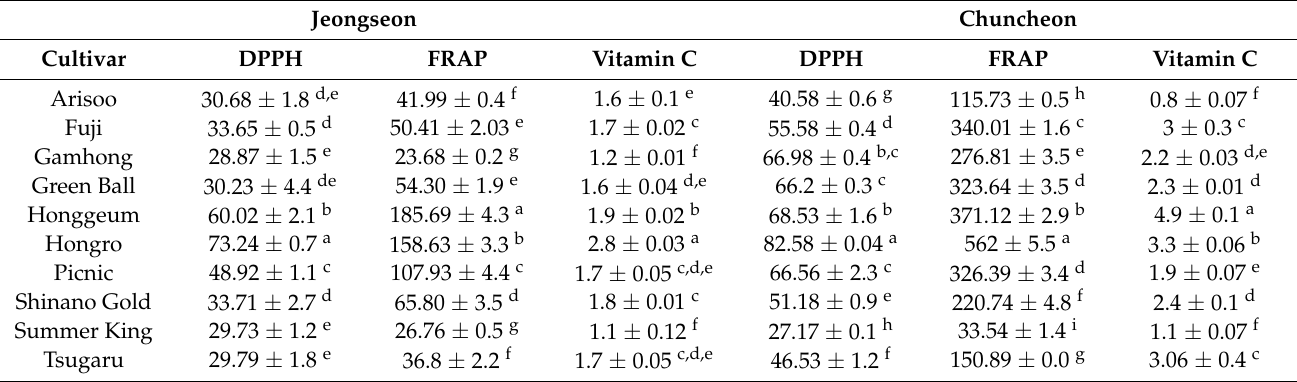
Table 3. Variation of antioxidant activities in unripe fruits of 10 apple cultivars from the two locations. Jeongseon Chuncheon